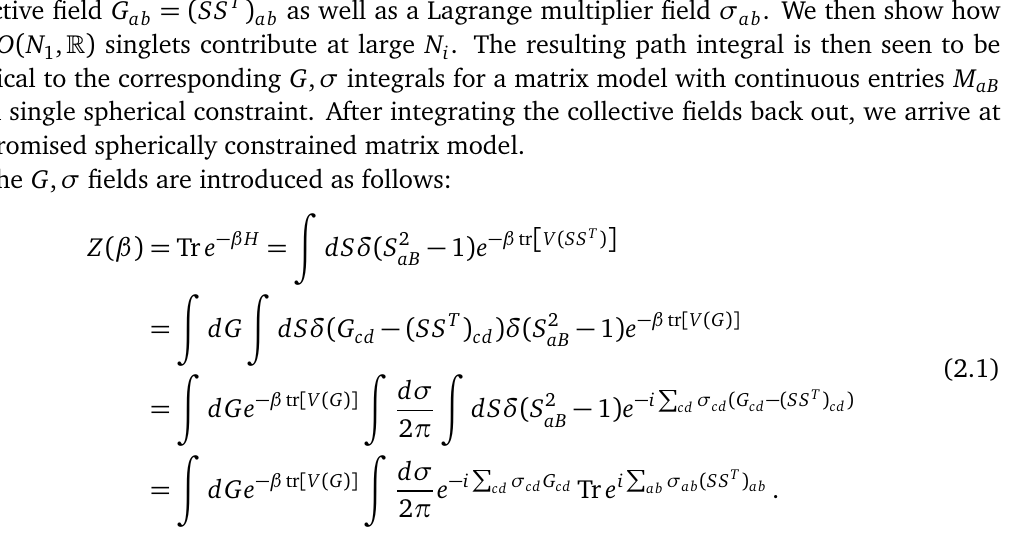
(cid:2) ( (cid:3) + (cid:2) ( (cid:3) SS T ) 4 SS T ) 5 tr . The black